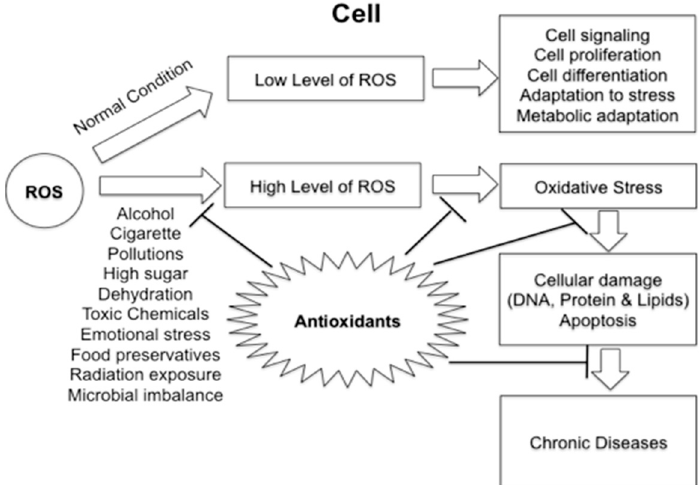
Figure 1. Prevention of oxidative stress by antioxidants. Antioxidants neutralize ROS related pathways. ROS play important roles in cell signaling, cell proliferation, cell differentiation, adaptation to stress and metabolic adaptation. Raised levels of the ROS could lead to cellular damage and chronic disease development. Antioxidants modulate ROS levels and prevent cell damage through various mechanisms.